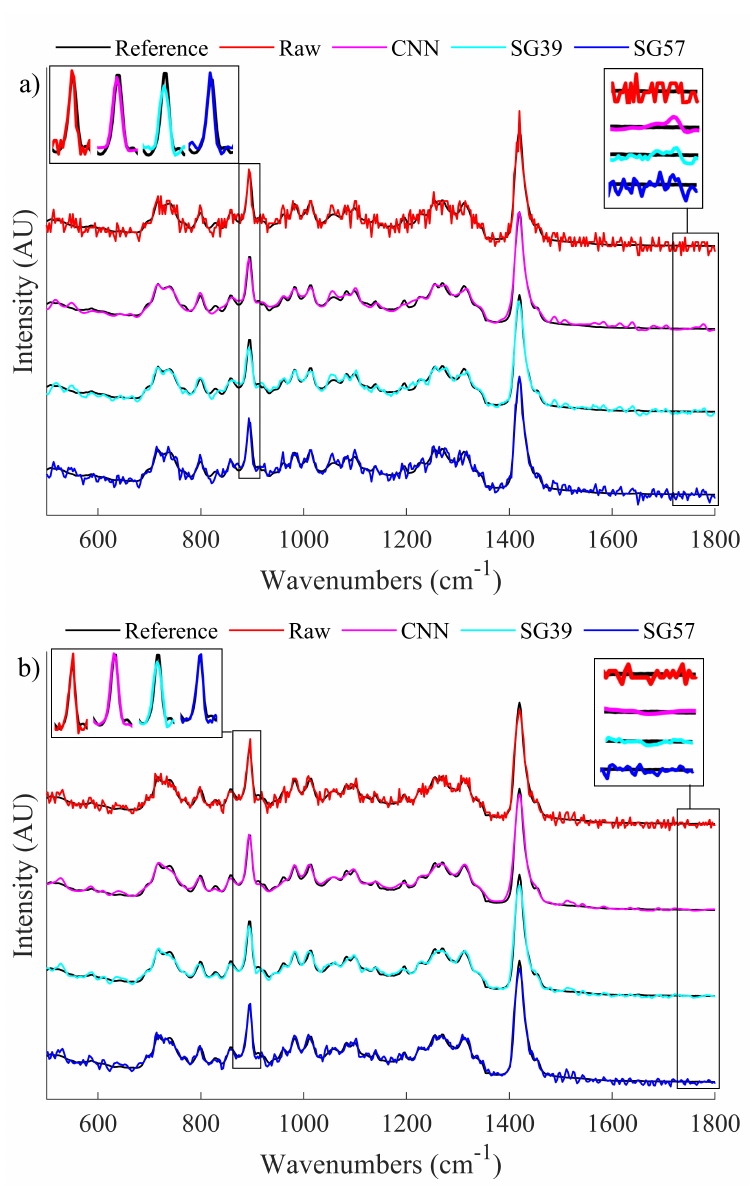
Figure 5. A visual comparison of the denoising properties of the SG filters when compared to the CNN and the raw data. Areas of interest, i.e. a sharp local peak and an area of low frequency noise, have been enlarged to highlight the difference in performance. ( a ) Illustrates a sample spectrum of raw SNR 25 as well as its denoised counterparts and ( b ) Illustrates a sample spectrum of raw SNR 40 as well as its denoised